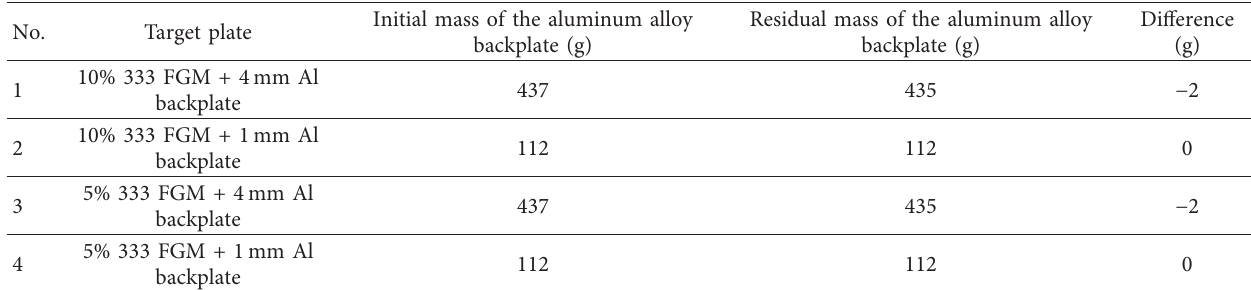
Table 9: Aluminum alloy backplate mass